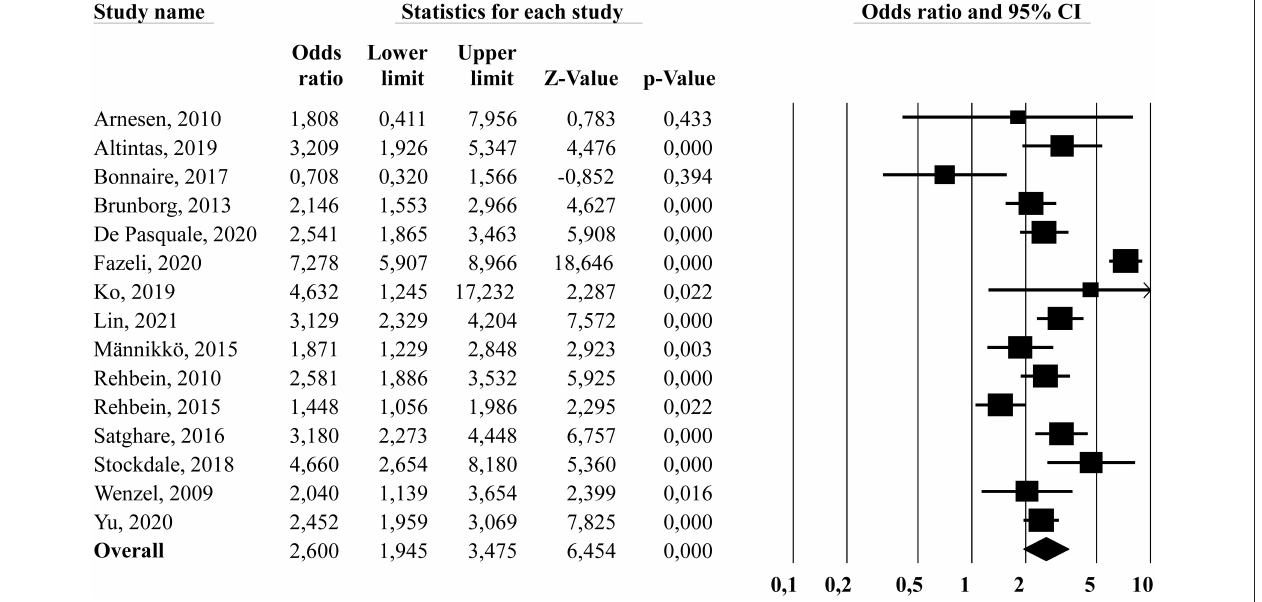
to OR = 2.81, 95% CI (2.11, 3.76). The Orwin’s fail-safe N